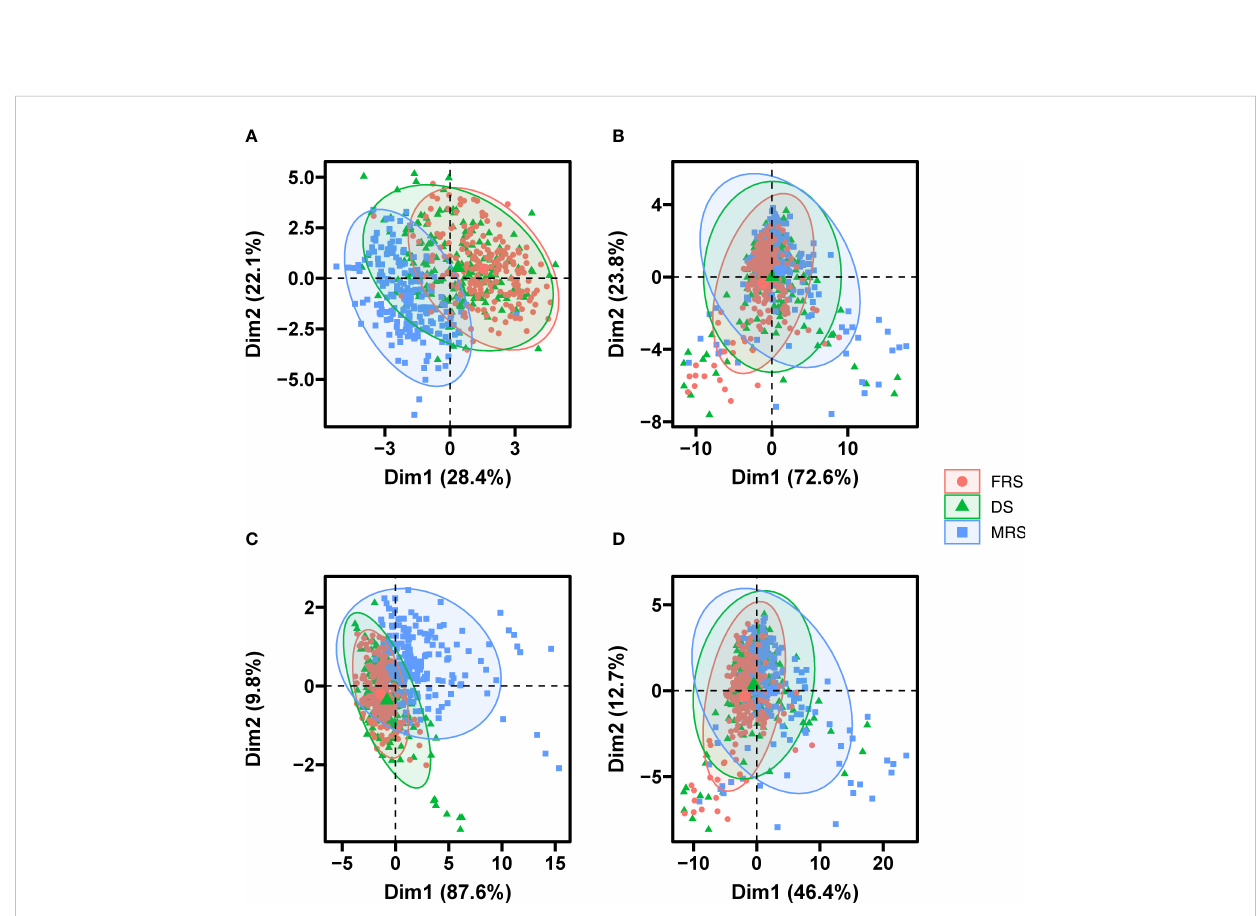
FIGURE 5 PCA score plot of seeds of different maturity stages and grain positions based morphological data (A) , multispectral data (B) , auto fl uorescence data (C) , and multi-source fusion data (D)